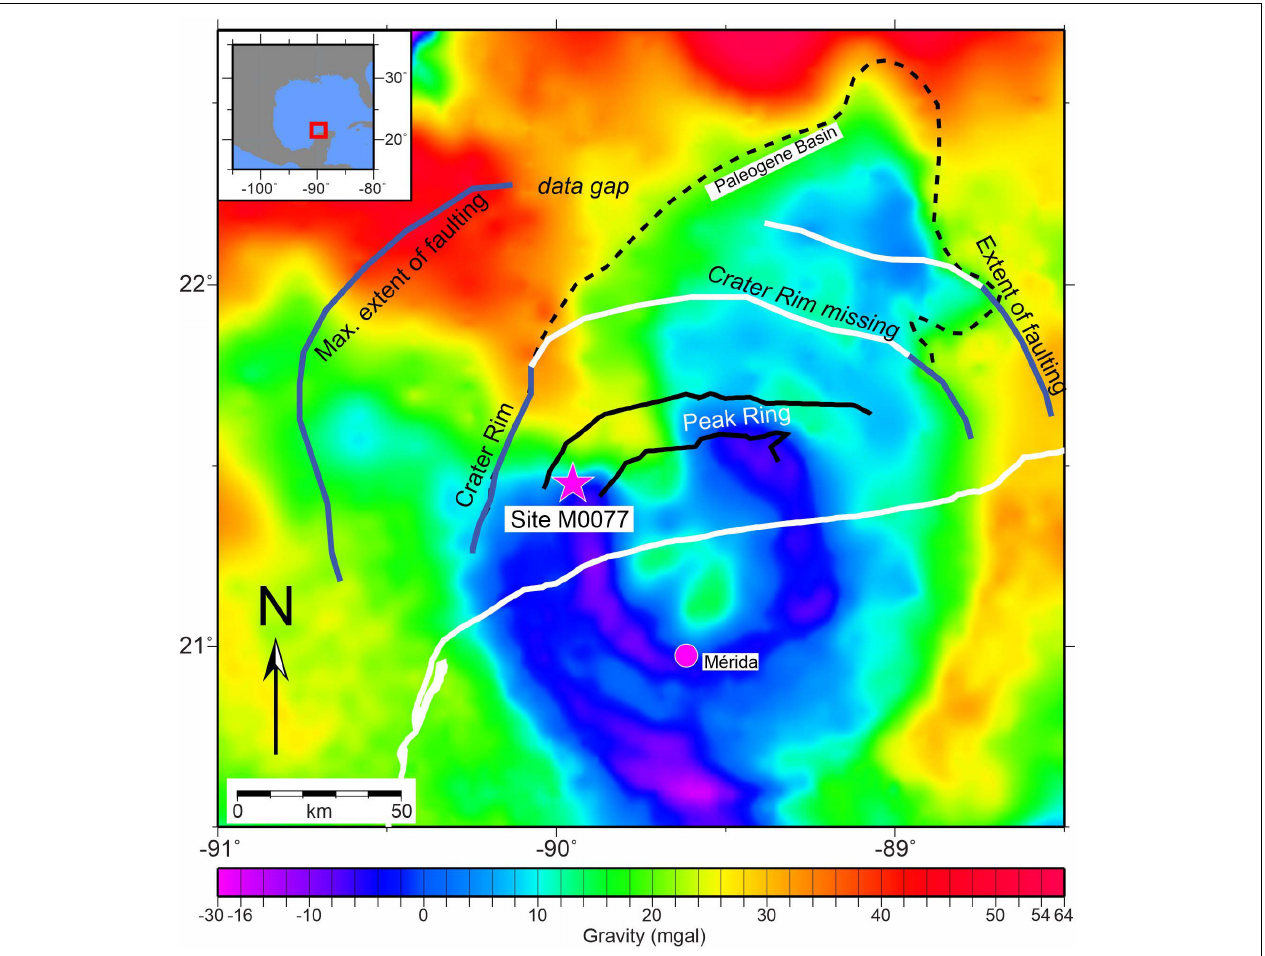
FIGURE 1 | Location of the drilling site M0077 in the Chicxulub crater, Yucatán peninsula, México as seen using gravity data. Figure is adapted from Gulick et al.